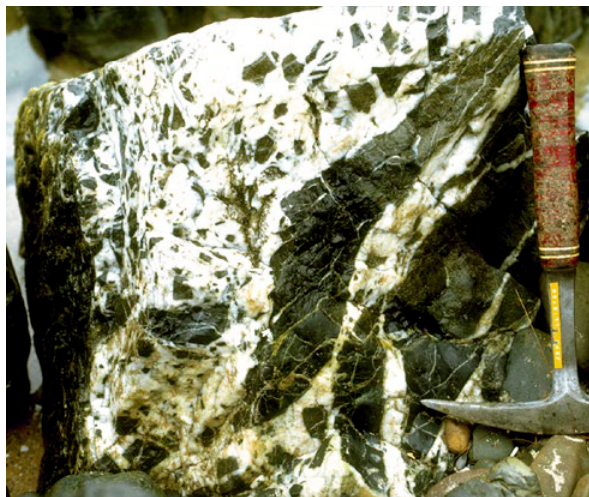
Figure 29. A discordant quartz vein in basic rock carries pieces and slabs of wallrock “suspended” in the quartz. Some crystal cavities or vugs are developed near the centre of the vein. If the quartz in the vein were deposited from solution it introduces the problem of suspending the fragments while sufficient quartz is precipitated to support them. Injection of the vein material as thixotropic silica gel is clearly indicated. Rheopexy (instant resetting as gelatinous fluids approach cessation of flow) would support fragments and preserve their delicate projections. After injection and resumption of a gela- tinous condition the crystal cavities indicate synerectic shrinkage during dewatering and finally crystallisation. The vein outcrops on the south coast of N.S.W. between Bungen and Goalen.